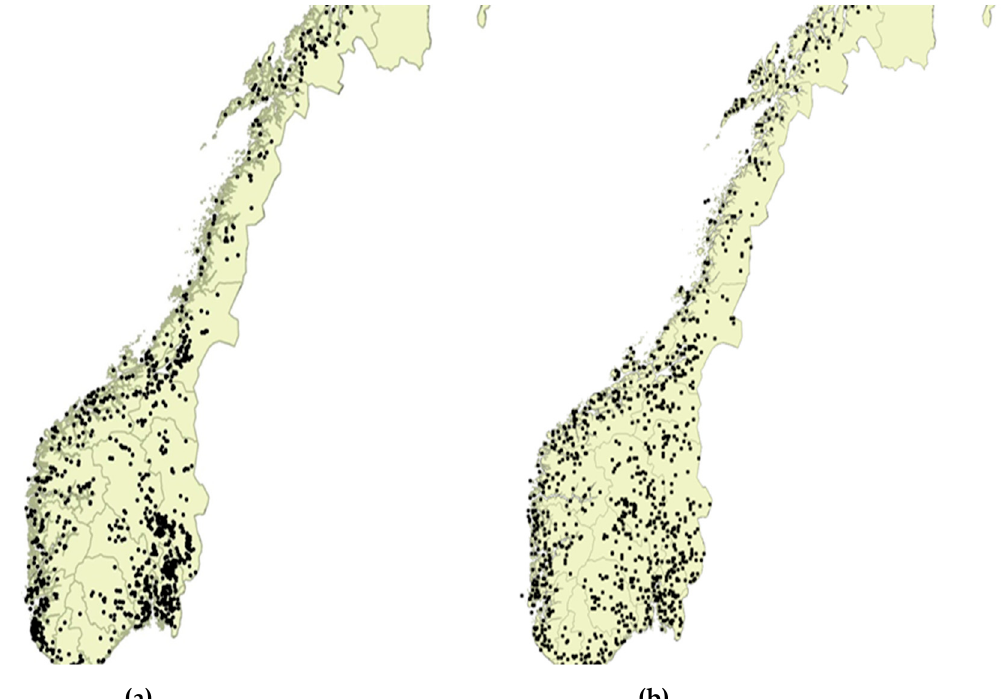
Figure 1. Distribution of 3Q monitoring squares in Norway: ( a ) the initial 3Q sample, where each point represents the location of a 1 × 1 km monitoring square with agricultural land at its center (947 squares); ( b ) the new data sample, a random selection of squares containing agricultural land, regardless of whether it is at the center or not (1000 squares).